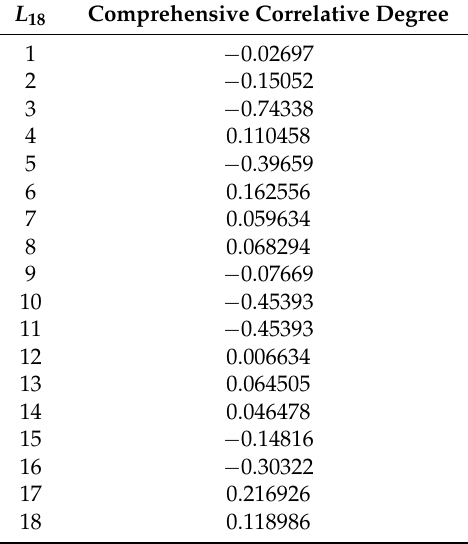
Table 5. Comprehensive Correlative